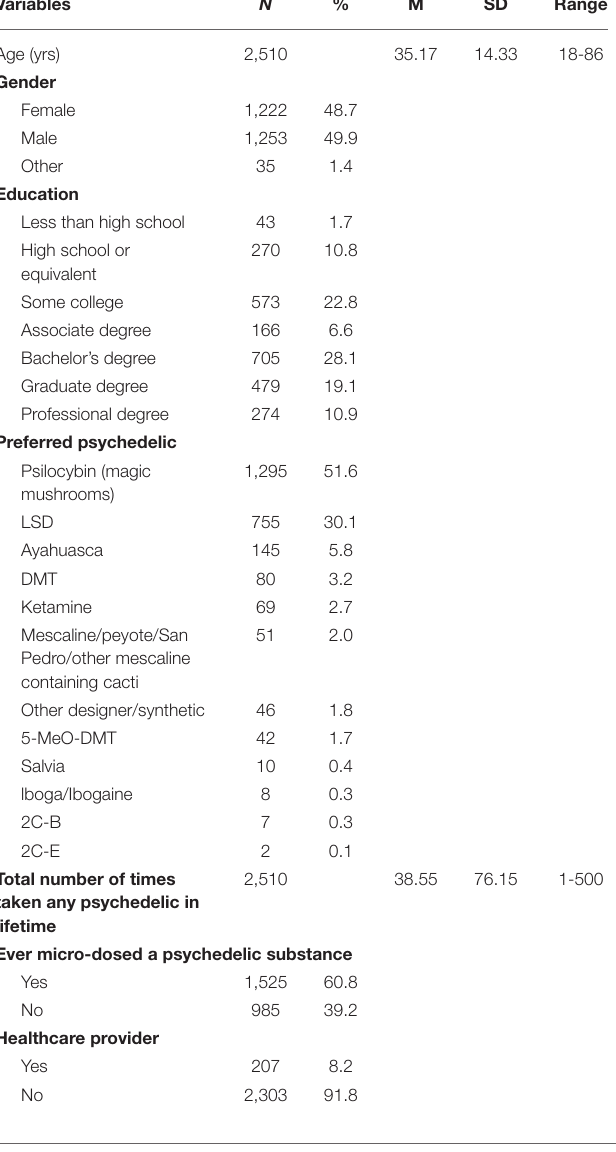
TABLE 2 | Depression, anxiety, and well-being scores for pre- and post-psychedelic